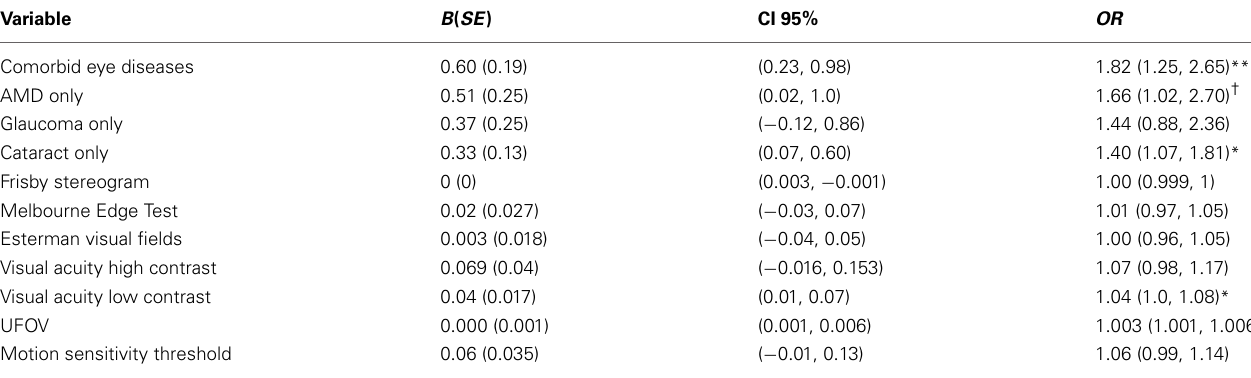
Table 2 | Association between eye disease and visual function and depressive